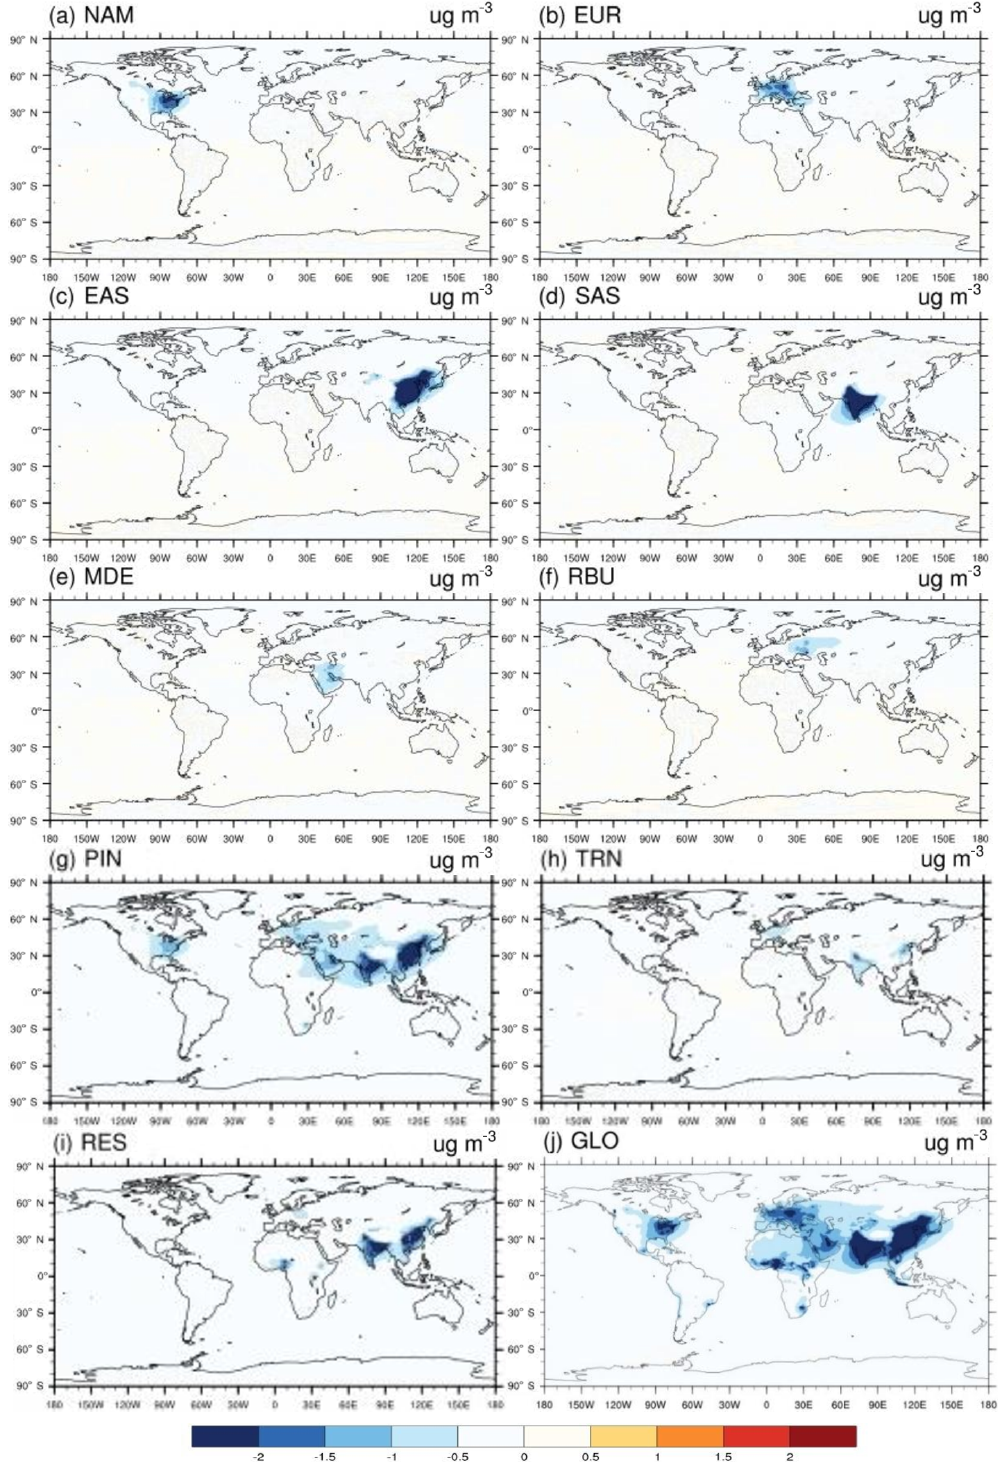
Figure 2. Global difference in multi-model annual mean PM 2 . 5 concentrations (µgm − 3 ) in 20% emission reduction scenarios relative to the baseline for the year 2010 in (a) North America (NAM), (b) Europe (EUR), (c) East Asia (EAS), (d) South Asia (SAS), (e) the Middle East (MDE), and (f) Russia–Belarus–Ukraine (RBU), the (g) power and industry (PIN), (h) transportation (TRN), and (i) residential (RES) sectors, and (j) globally